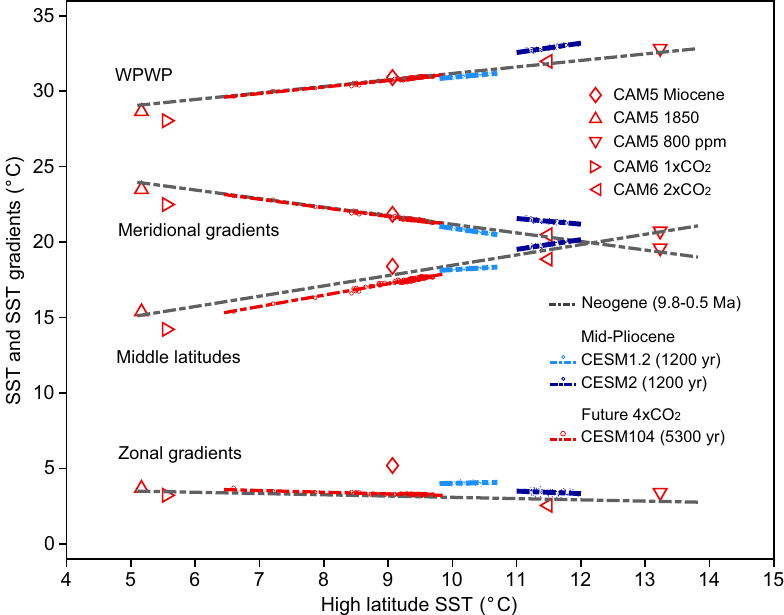
Fig. 5 | High latitude ampli fi cation from the past to the future. Meridional gradients are sea surface temperature (SST) differences between the Western Paci fi c Warm Pool (WPWP) and the high latitudes, and zonal gradients are SST differences between the WPWP to the Eastern Equatorial Paci fi c. Gray dash-dotted lines are regression lines of the 10-Myr SST data, the same as those represented in Fig. 3. Blue and red markers represent the model outputs generated by the Com- munity Earth System Model (CESM). Light and dark blue circles represent the equilibrium mid-Pliocene simulations conducted with CESM version 1.2 (CESM1.2) and2(CESM2)at400ppmCO 2 ,respectively 99 .Redcirclesrepresentthe5300-year SSTs generated by CESM 1.0.4 (CESM104) with abrupt atmospheric CO 2